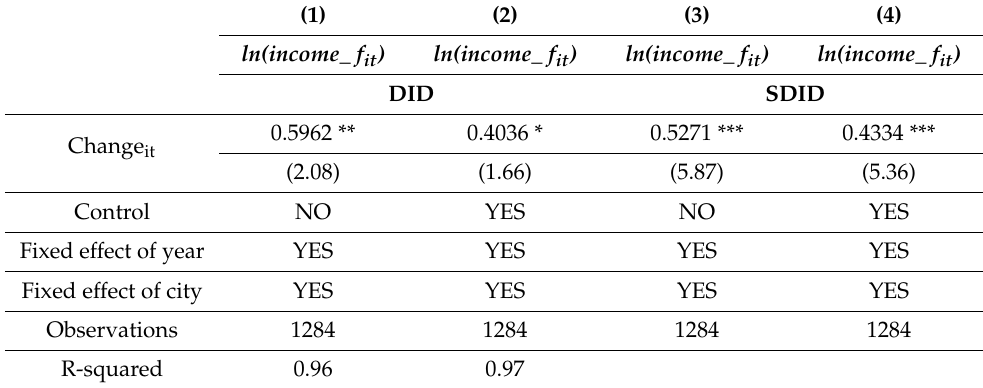
Table 2. Baseline regression results.